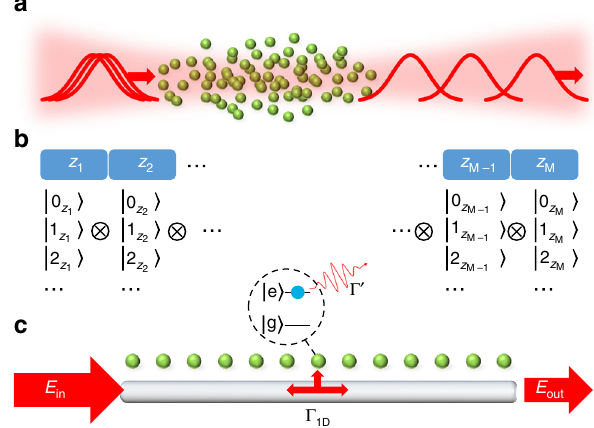
Fig. 1 Photon propagation in atomic ensembles. a Propagation through atomic ensembles with strong inter-atomic interactions can lead the quantum properties of the light to be strongly modi fi ed, represented here as crystalline-like output of photons from the medium. b In a typical approach to treat such quantum light propagation numerically, space is broken up into M discrete units centered at positions z j , with corresponding local Fock (cid:1) (cid:1) (cid:3) (cid:3) (cid:1) (cid:1) ; 1 ; ¼ for the photons. The equations of motion for the basis states 0 z z j j fi eld may be solved on this space, where the growth of the Hilbert